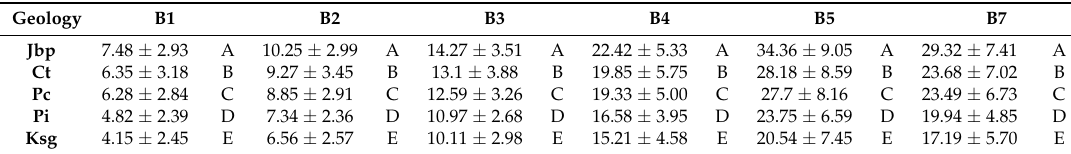
Table 3. Mean reflectance variation according to geology